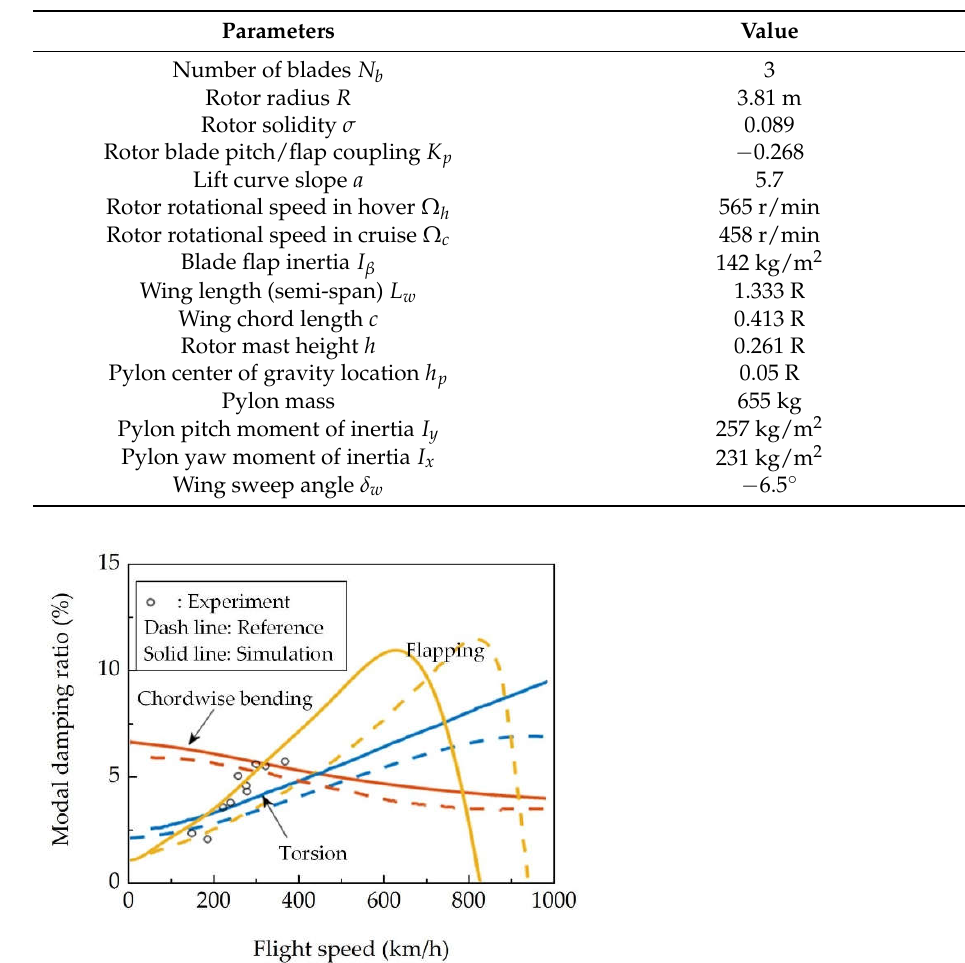
Table 1. Fundamental parameters of the Bell test model [25].